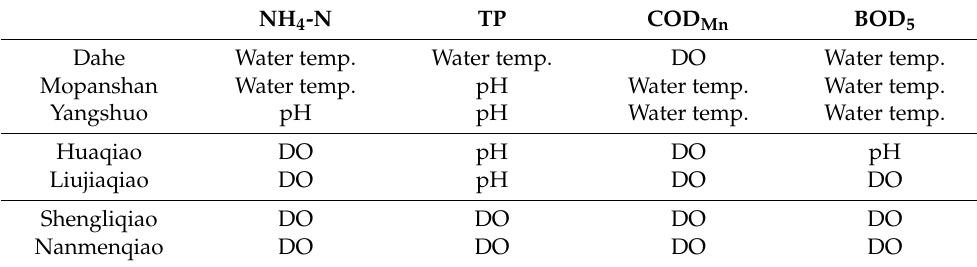
Table 5. Dominant factors of different monitoring